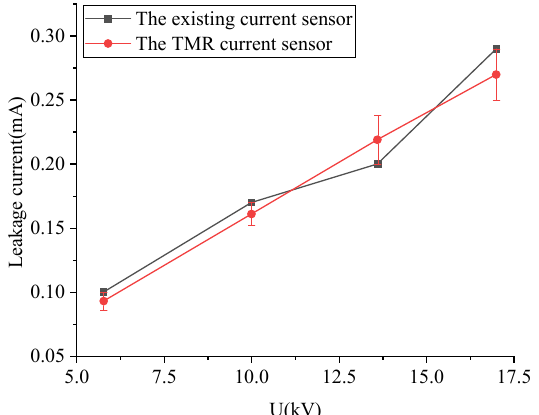
Figure 18. Comparison of leakage current at different voltages measured by the TMR sensor and the existing sensor.